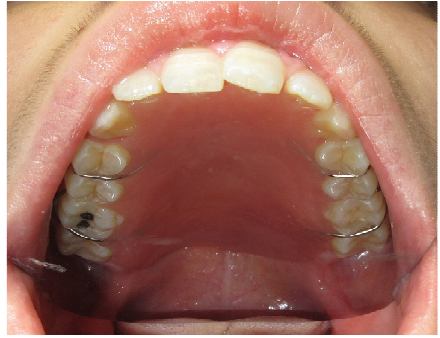
Figure 9. Day one before the application of the palatal plate.